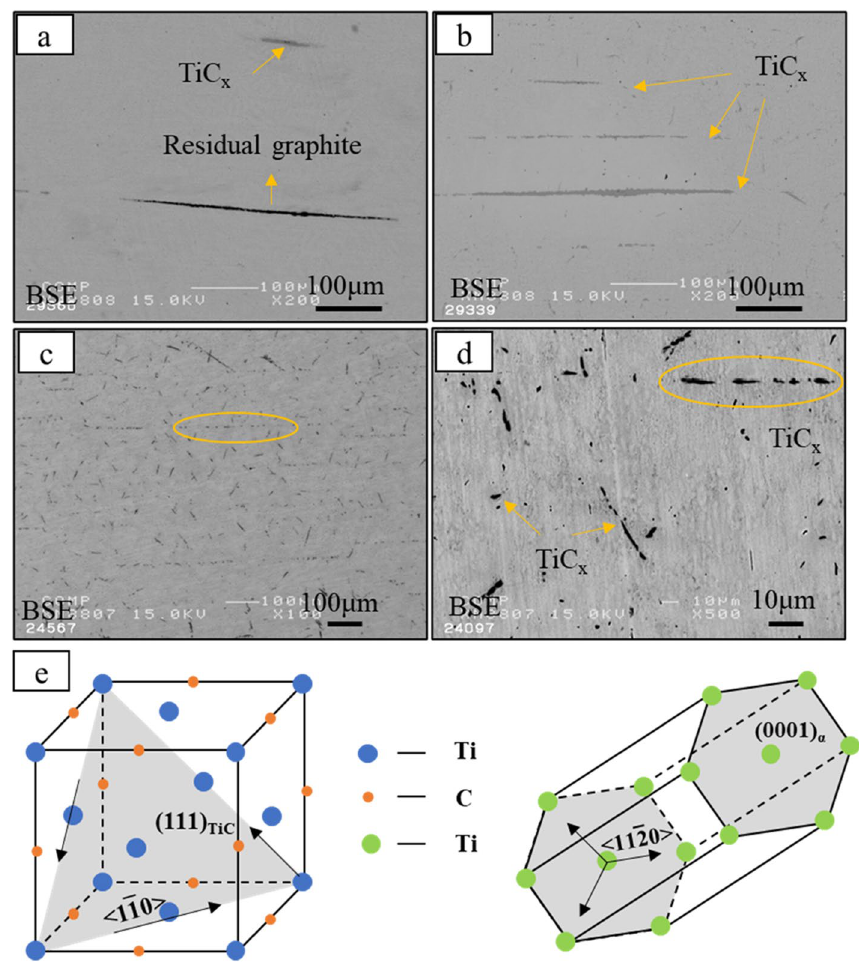
Figure 7. ( a ) BSE images of TiC reinforced TMCs sintering at 1273 K for 0.6 ks; ( b ) 1473 K for 0.6 ks; ( c ) and ( d ) 1473 K for 3.6 ks; ( e ) The schematic diagram of the ORs of TiC and α-Ti.